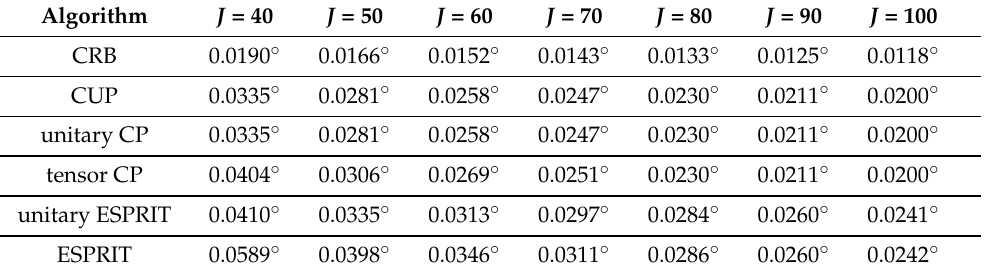
Table 5. RSME of angle estimation versus Snapshots.